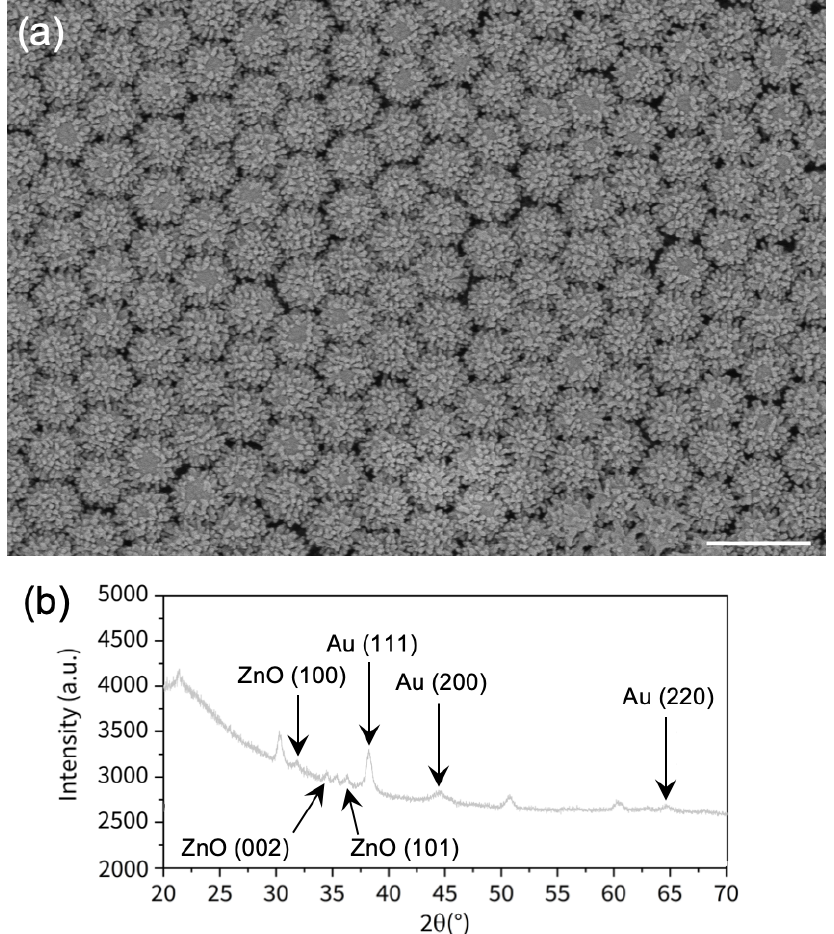
Figure 1. ( a ) SEM image of assembled zinc oxide nano-urchins covered by the 50 nm-thick Au layer (scale bar = 1000 nm). ( b ) XRD pattern of Au/ZnO